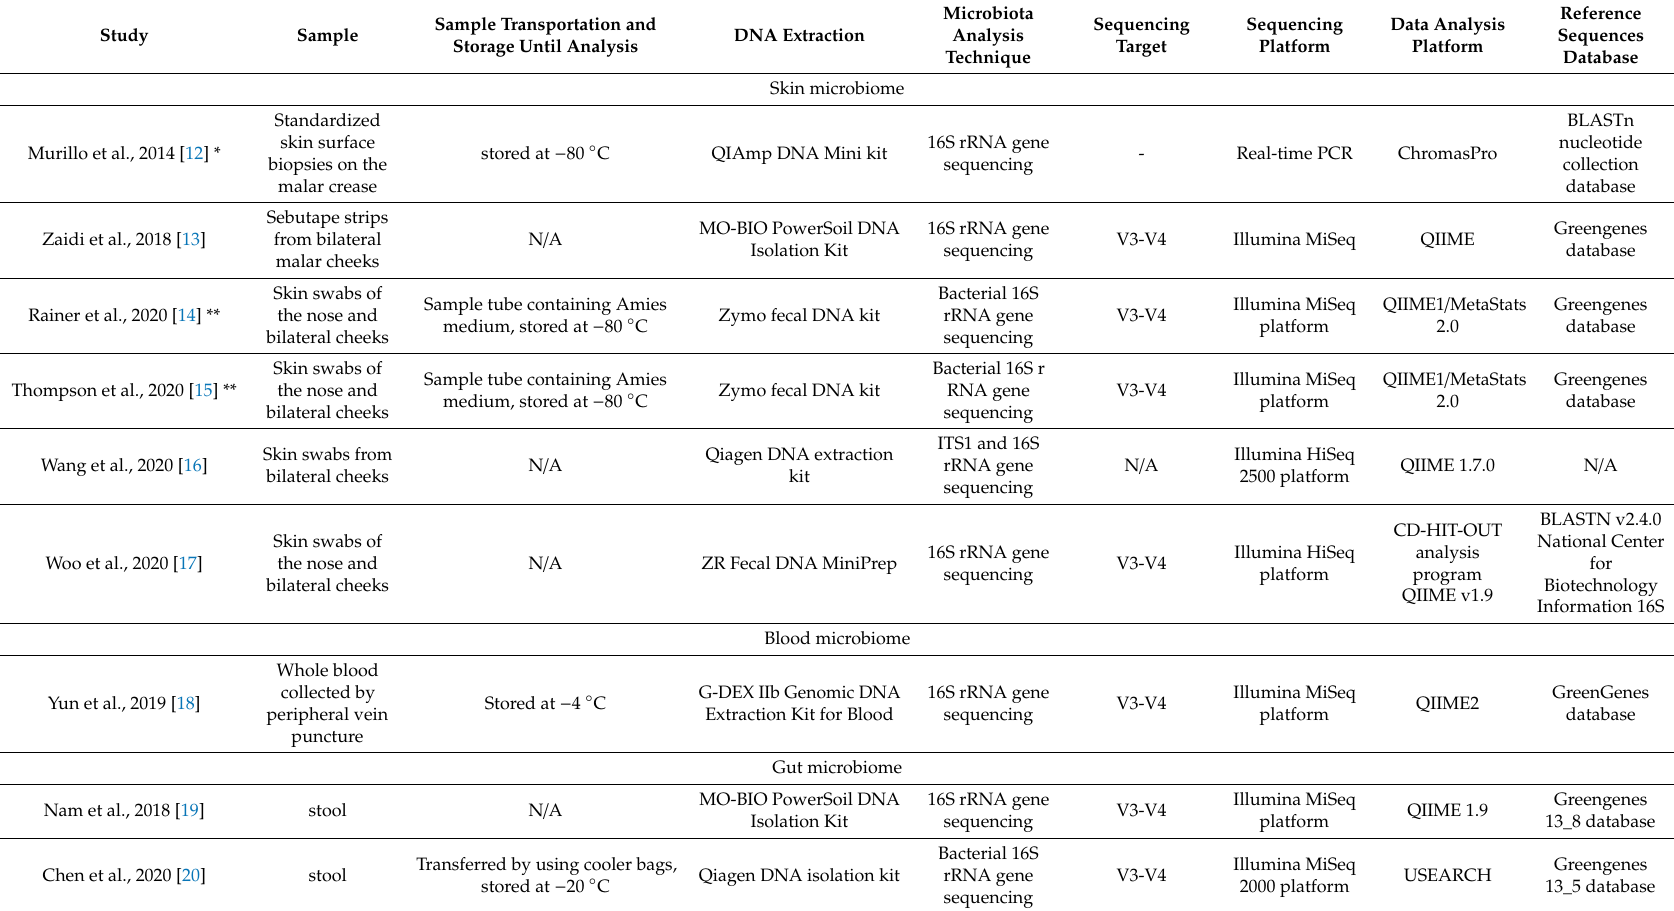
Table 2. Methodology of the included